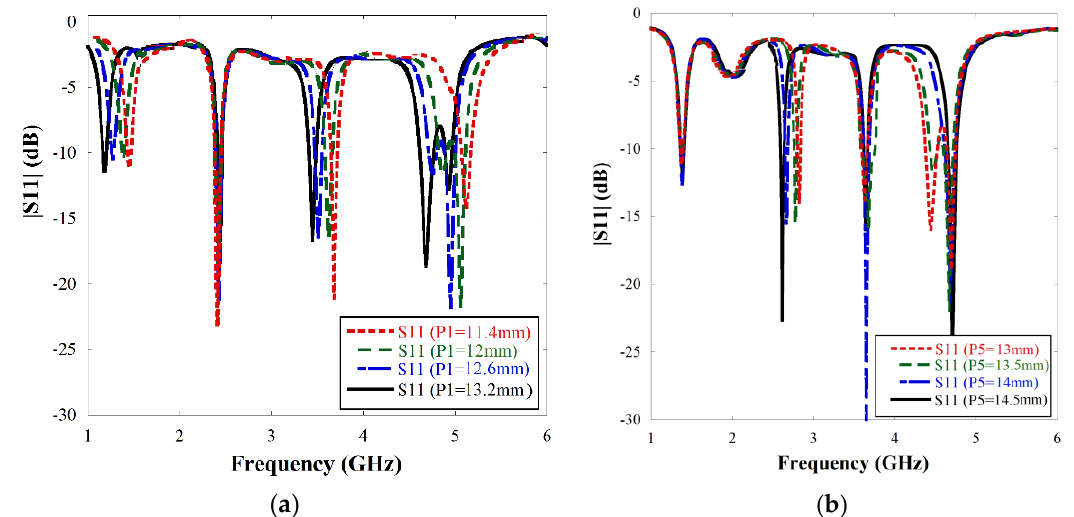
Figure 5. |S11| graph of the single unit meander line antenna variation of length of ( a ) P 1 and ( b ) P 5 .